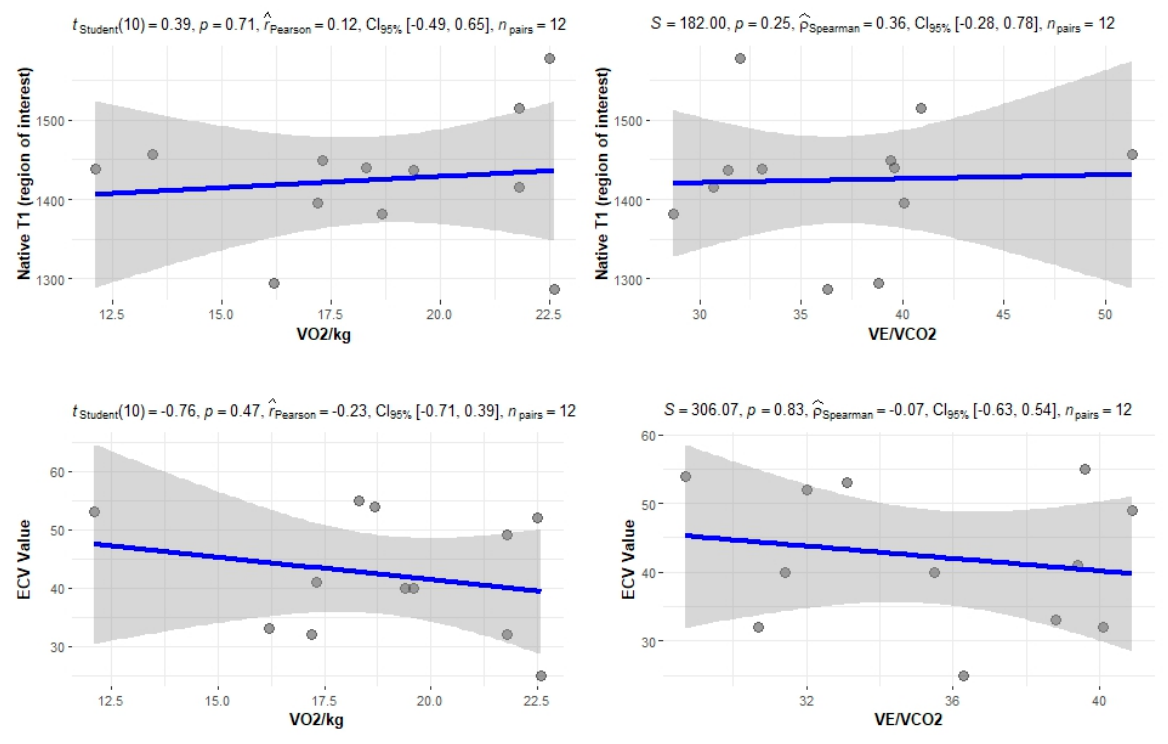
Figure 3. Correlation between CPET parameters and cardiac MRI findings.